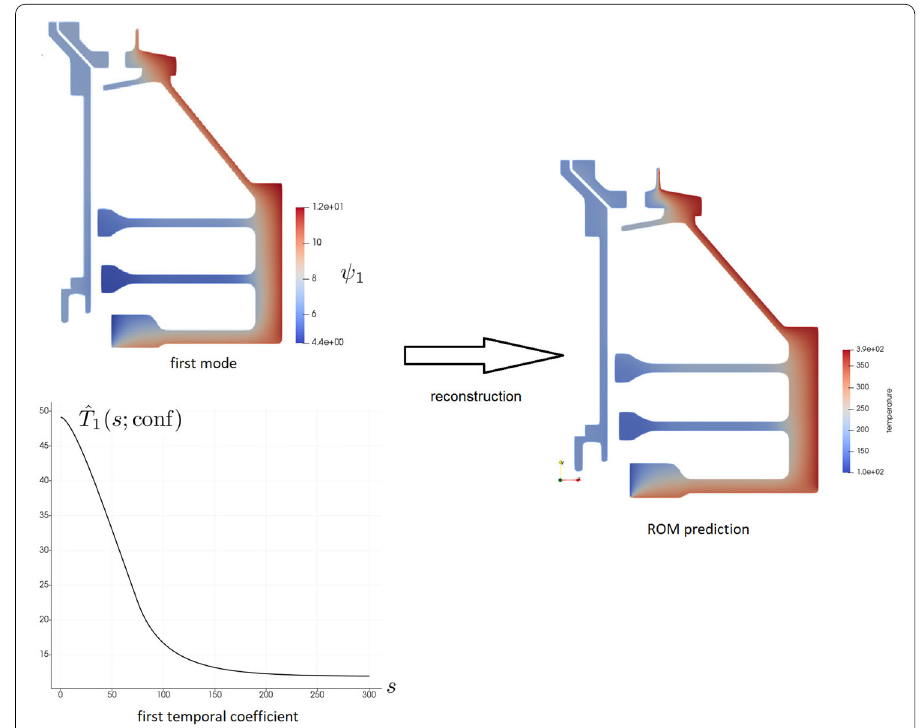
Fig. 3 PXDMF format reconstruction of the ROM prediction on-the-fly; top-left: first POD mode (cid:15) 1 , bottom-left: first temporal coefficient ˆ T 1 ( s ;conf) with respect to the time step s , see (9), right: solution temperature field at the final time step